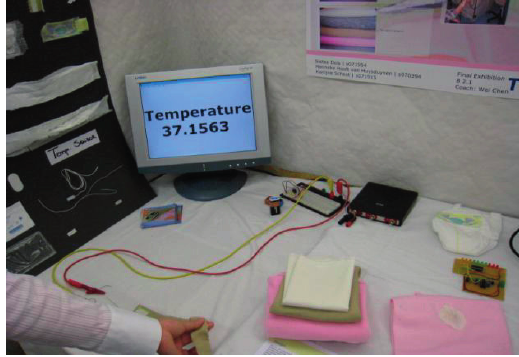
Figure 6. The setup of the temperature monitoring demonstration [10]. Copyright © 2010 Association for Computing Machinery, Inc.